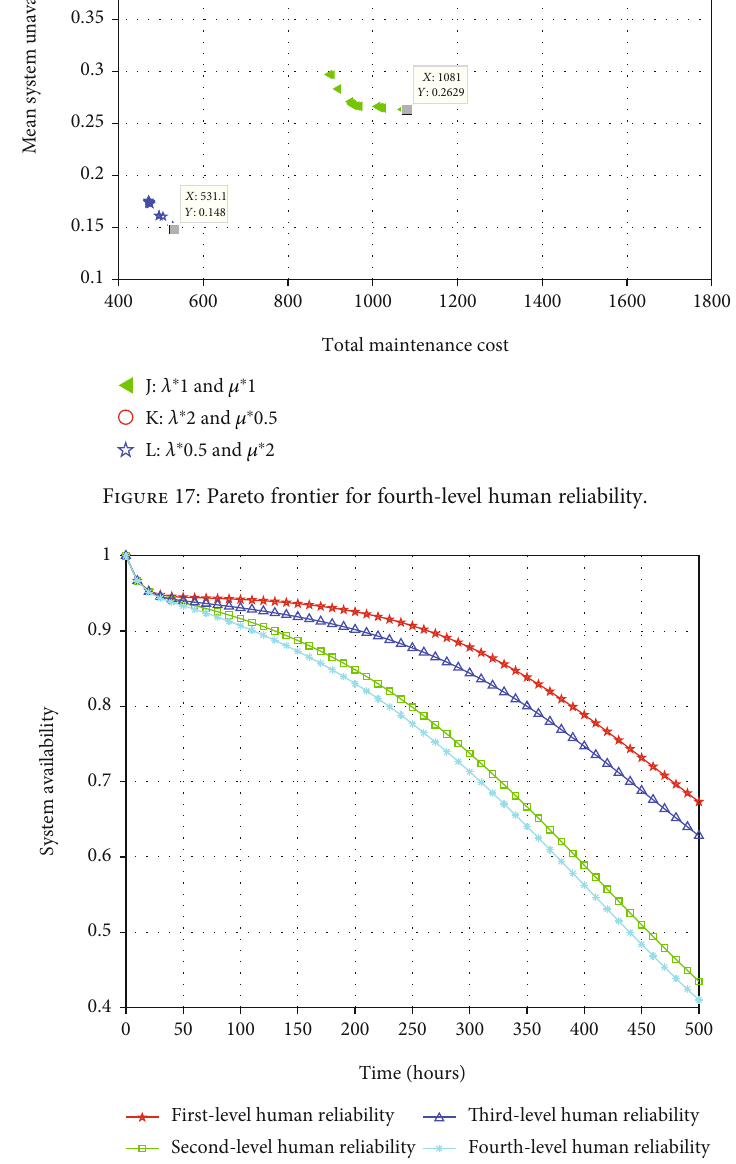
Figure 18: System availability trajectory with failure and repair rates